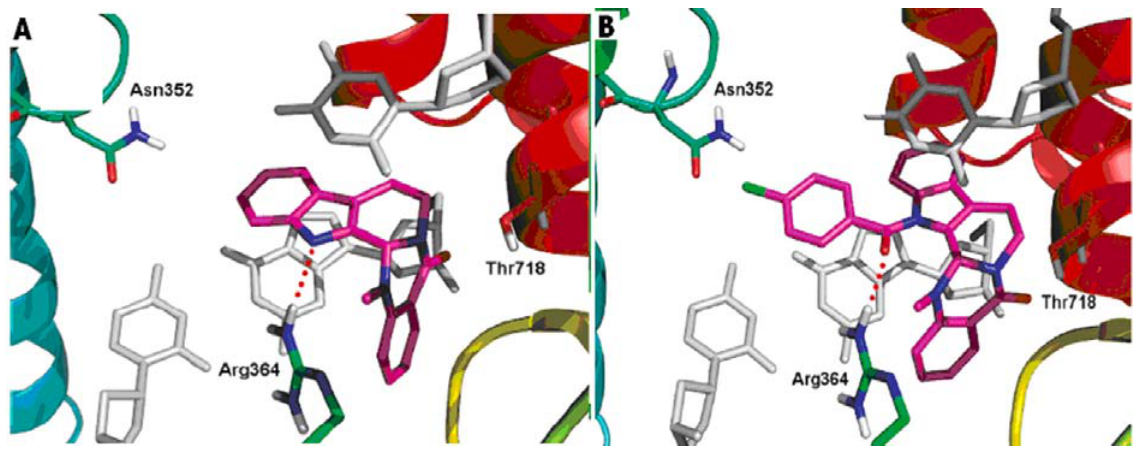
Figure 5. Binding modes of evodiamine and 3-(4-chlorobenzoyl) evodiamine in the active site of topoisomerase I-DNA